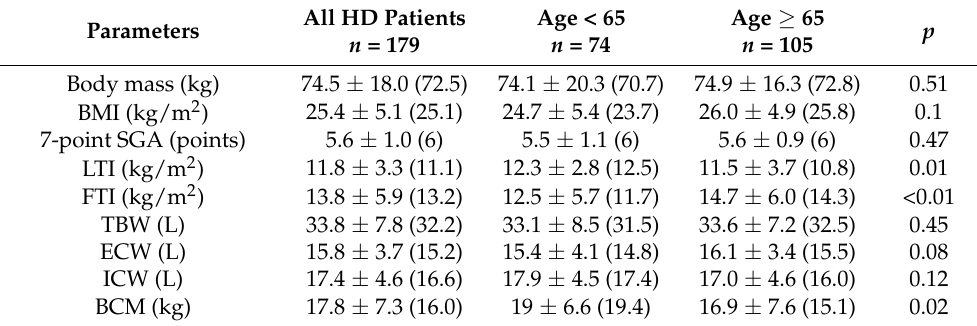
Table 2. Results of nutritional